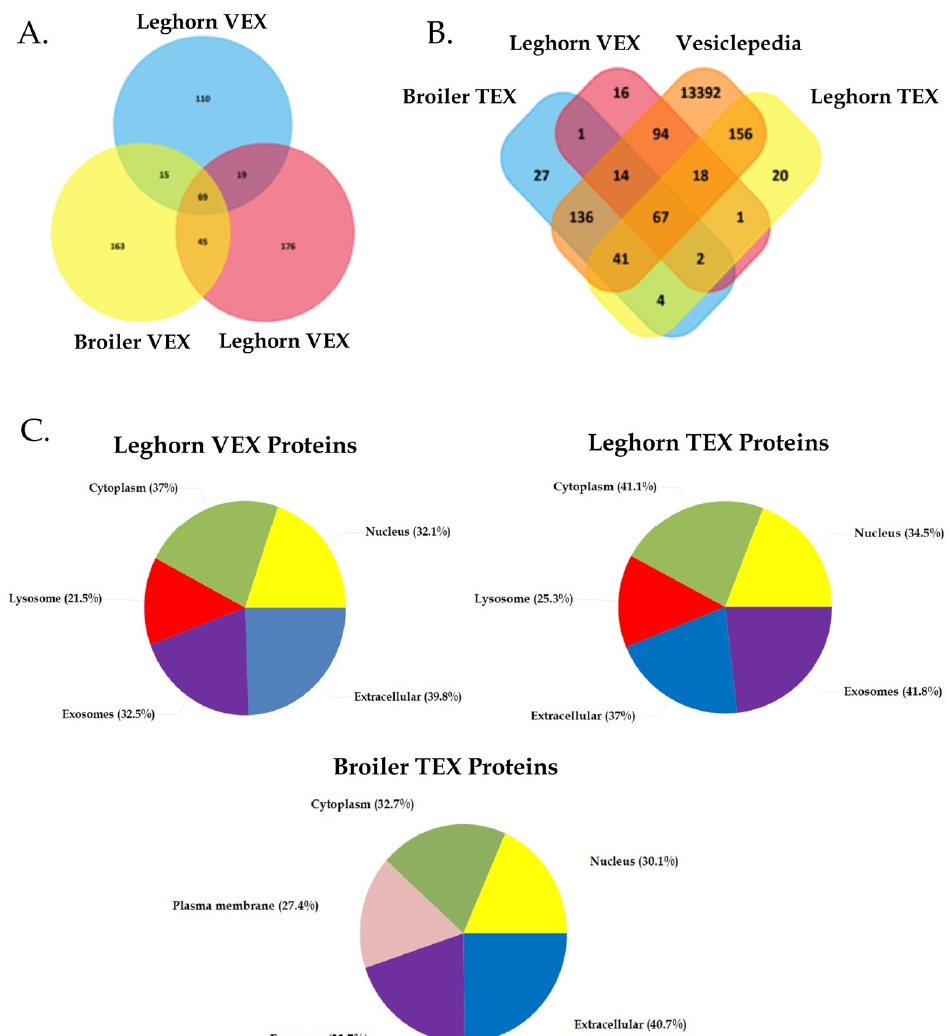
Figure 7. Proteomic analysis of leghorn VEX, TEX and broiler TEX. Pane ( A ) shows a Venn diagram of proteins identified in leghorn VEX, leghorn TEX and broiler TEX. Panel ( B ) shows a Venn diagram of datasets compared to the Vesiclepedia database of proteins [37], see also Supplementary files S5– S7). Panel ( C ) shows the Funrich enrichment of subcellular localization of proteins identified in